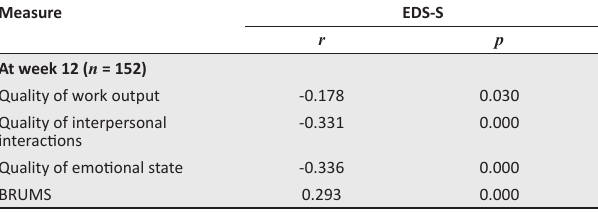
TABLE 6: Correlations between baseline Emotional Dysregulation Scale-Short Form scores and self-rated performance at end of deployment (week 12). Measure